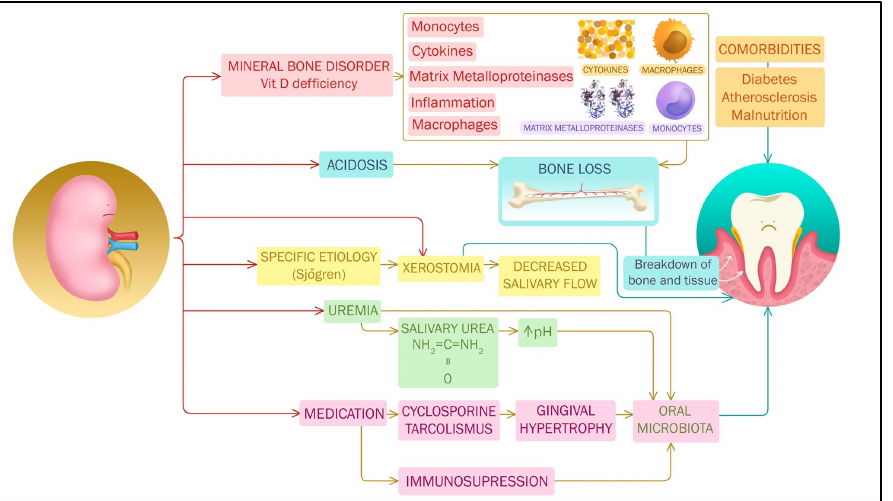
Figure 2. Homeostatic imbalances caused by CKD may be involved in pathogenesis of PO in various ways: vitamin D deficiency may impair immune response and conjugated with other mineral bone disorders and acidosis may contribute to periodontal bone loss; xerostomia in advanced CKD, especially dialysis patients and/or due to specific etiologies such as Sjogren syndrome, impairs salivary flow; uremic toxins, increased salivary pH, and specific medication, especially immunosuppressants, cause dysbiosis; comorbidities of CKD may independently influence PO.